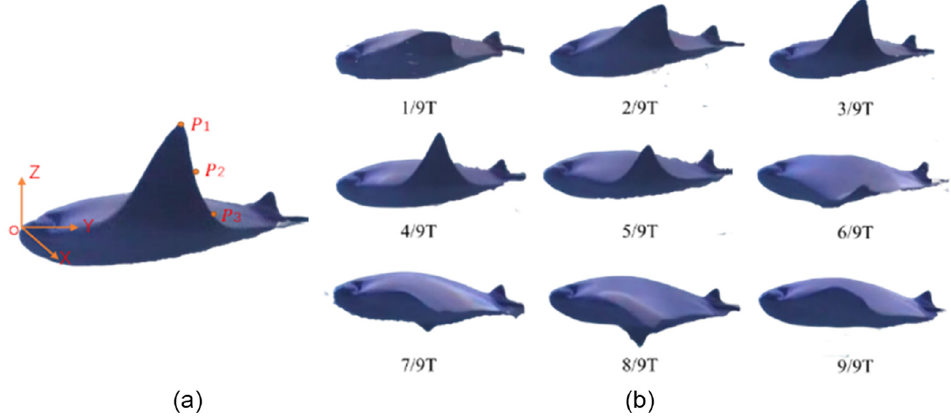
Figure 1. ( a ) Coordinate system establishment. ( b ) Forward motion sequence.